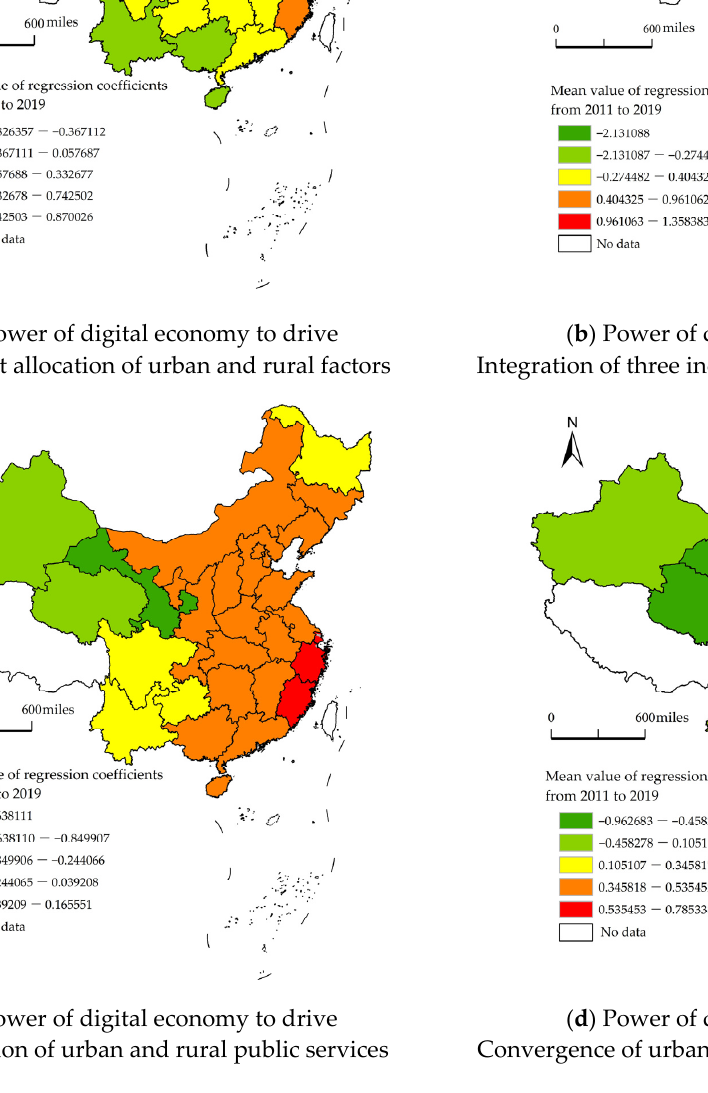
Figure 3. Estimated distribution of the regression coefficients of the GTWR model for the influences of the digital economy on the four dimensions of urban-rural integration. (Drawing review number: GS (2020) 4618 (supervised and manufactured by the Ministry of Natural Resources of the People’s Republic of China). It is a base map without modification, in which data from Tibet, Hong Kong, Macao, and Taiwan are excluded).